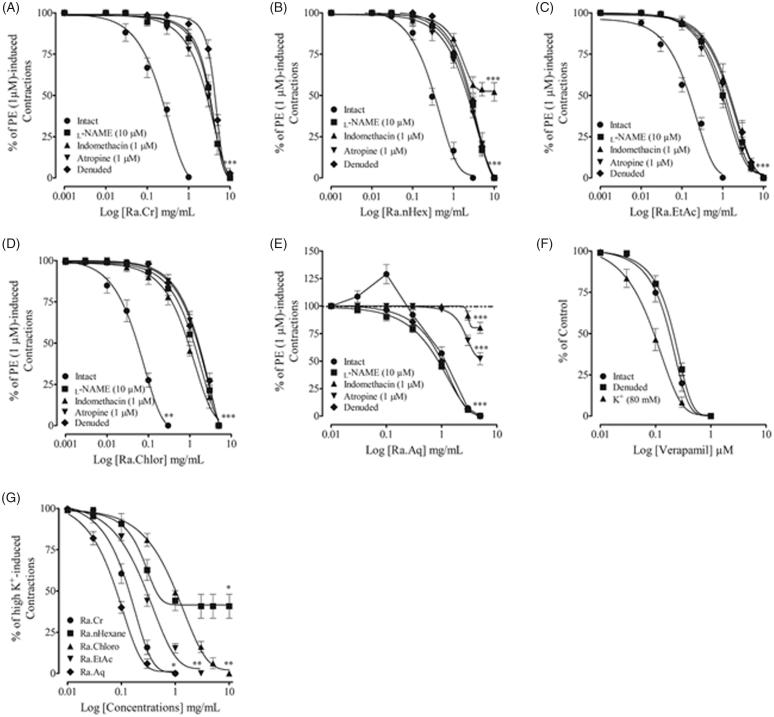
Response of the crude extract of Rumex acetosa (Ra.Cr) and its fractions on assorted parameters in isolated rat aorta preparations. (A–D) Endothelium-dependent vasorelaxant response of the crude extracts of Rumex acetosa (Ra.Cr); n-hexane (Ra.nHex); ethyl acetate (Ra.EtAc) and chloroform (Ra.Chlor) fractions in aortic rings precontracted with PE (1 µM). (E) Endothelium-dependent contractile and endothelium-independent relaxant effect of the aqueous (Ra.Aq) fraction in aortic rings precontracted with PE (1 mM). (F) The endothelium-independent vasodilator effect of verapamil. (G) The combined vasodilator effect of Ra.Cr, Ra.nHeaxane, Ra.Chlor, Ra.EtAc and Ra.Aq on K+ (80 mM)-induced contractions in isolated rat aorta rings. Values shown are mean ± SEM. Five to six determinations.